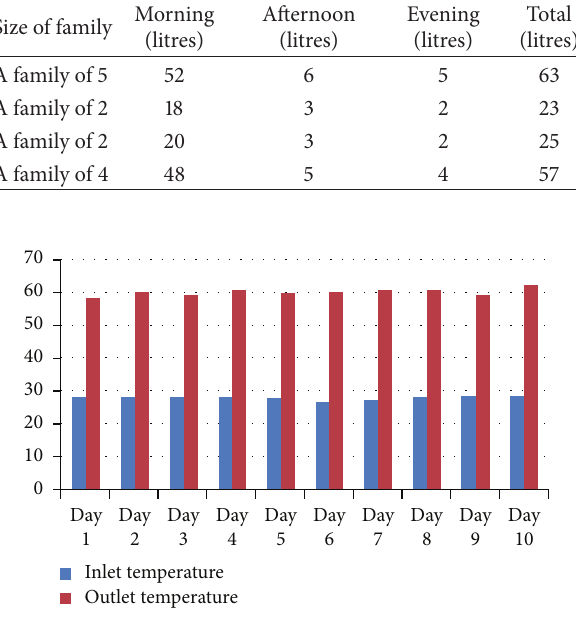
Figure 4: Inlet and outlet temprature of